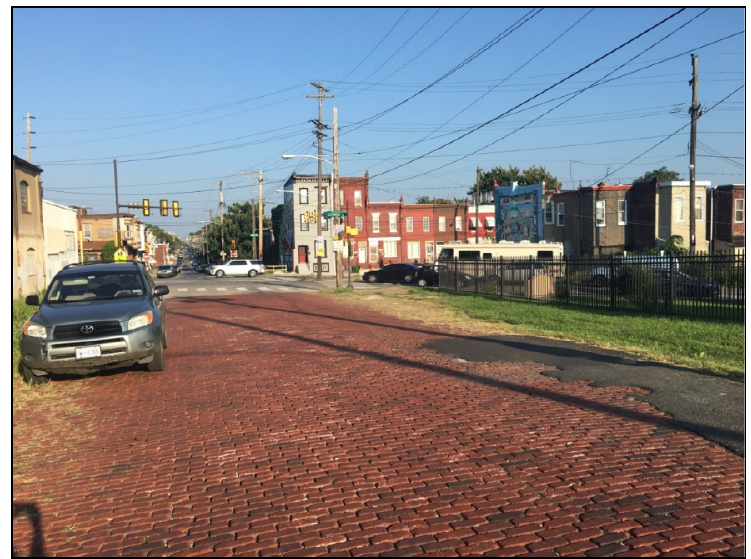
Figure 1. A Philadelphia street paved with brick historic paving material, located at 2900 W. Montgomery Ave.